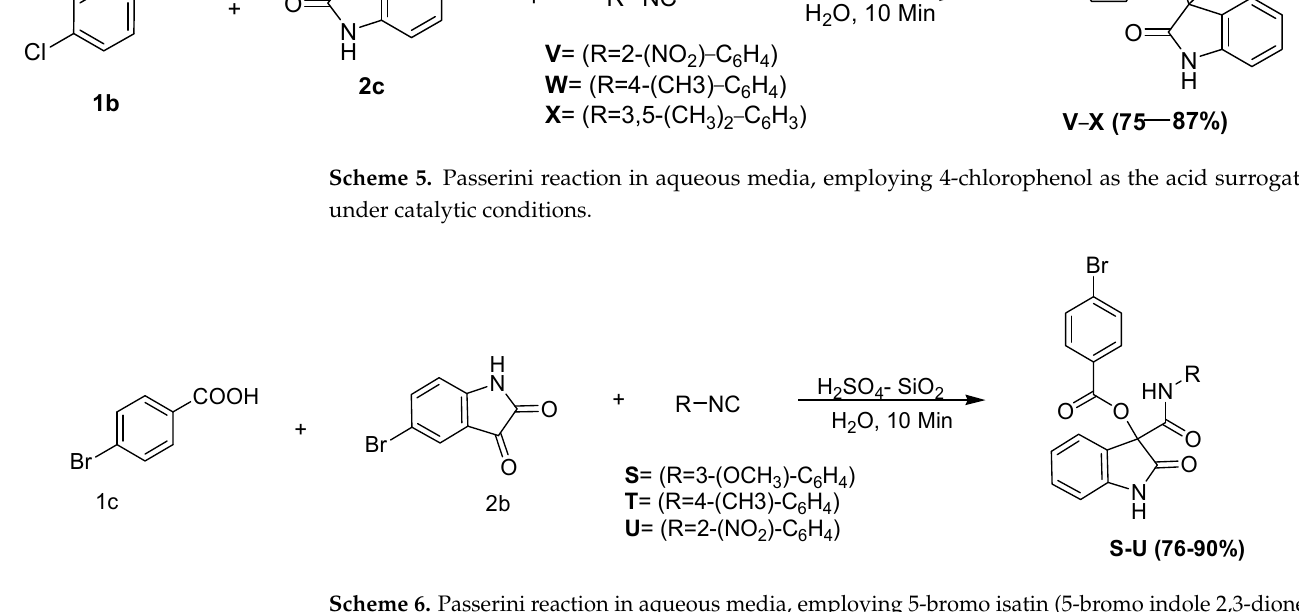
Scheme 6. Passerini reaction in aqueous media, employing 5-bromo isatin (5-bromo indole 2,3-dione)